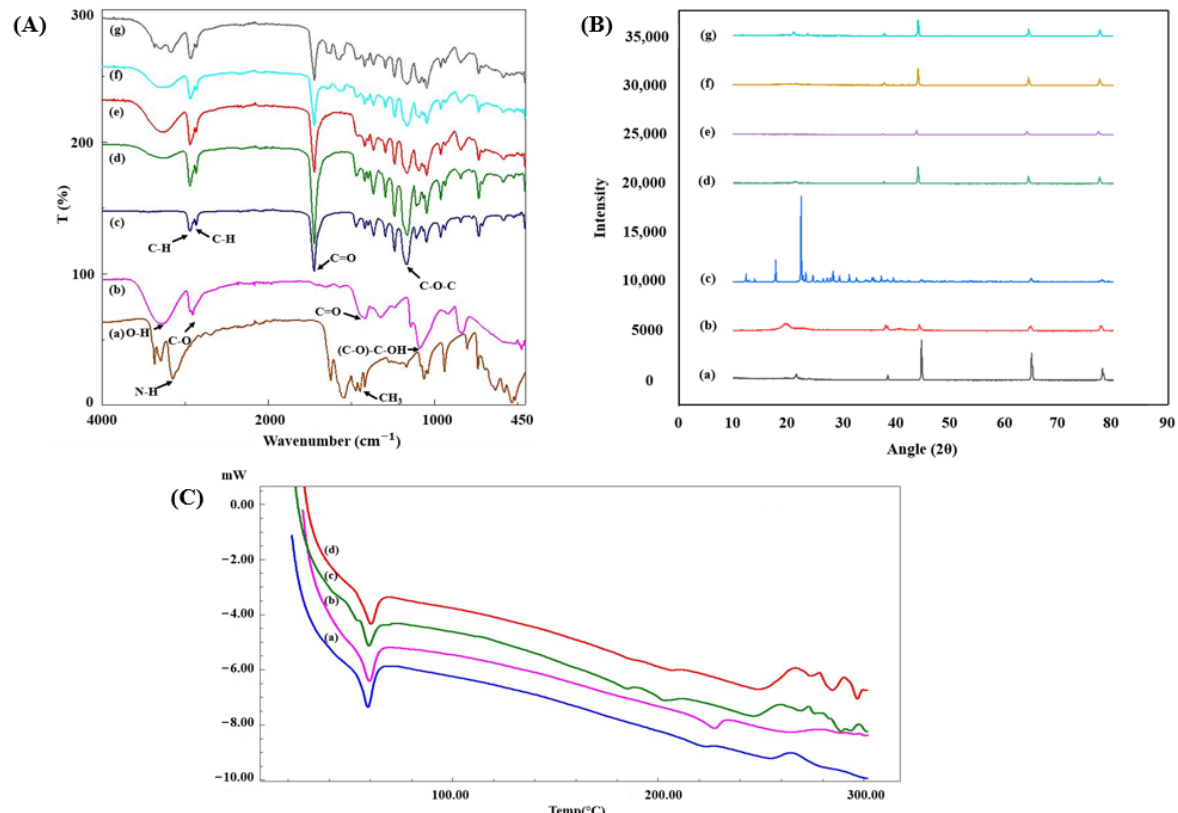
Figure 3. FTIR spectra of metformin (( A )), a), PVA (( A ), b), PCL (( A ), c), PCL/PVA (( A ), d), PCL/PVA/PCL (( A ), e), PCL/PVA-Met (( A ), f), and PCL/PVA-Met/PCL (( A ), g) scaffolds. XRD results of the PCL (( B ), a), PVA (( B ), b), metformin (( B ), c) and PCL/PVA (( B ), d), PCL/PVA/PCL (( B ), e), PCL/PVA-Met (( B ), f), and PCL/PVA-Met/PCL (( B ), g) scaffolds; DSC curves of PCL/PVA (( C ), a), PCL/PVA/PCL (( C ), b), PCL/PVA-Met (( C ), c), and PCL/PVA-Met/PCL (( C ), d) scaffolds.